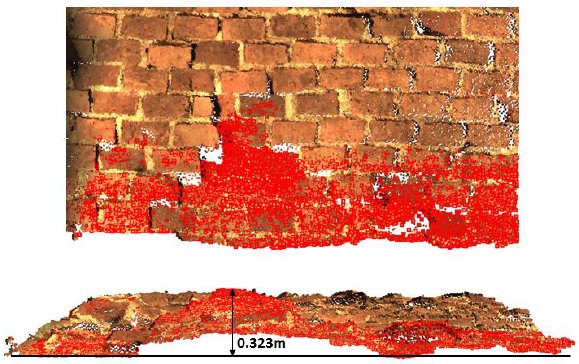
Figure 7. Maximum brick wall defects for